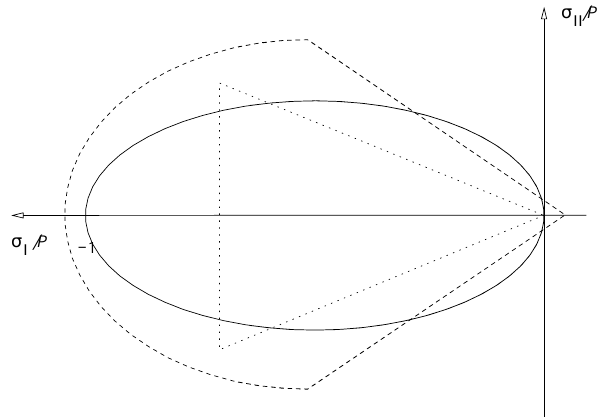
Fig. 2. The three yield curves discussed in the text plotted in stress invariant space; the elliptic, the modified Coulombic and the granu- lar model’s yield curves, depicted as solid, dashed and dotted lines,